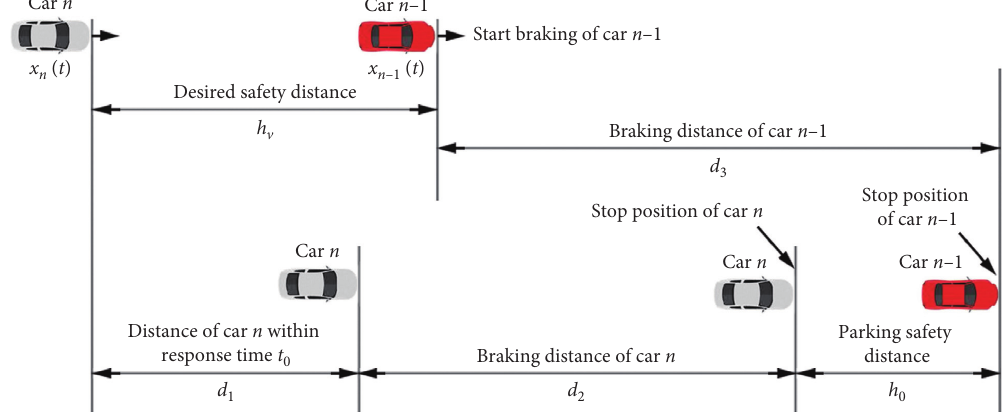
Figure 1: Schematic of the desired safety distance of the car-following scenarios during emergency